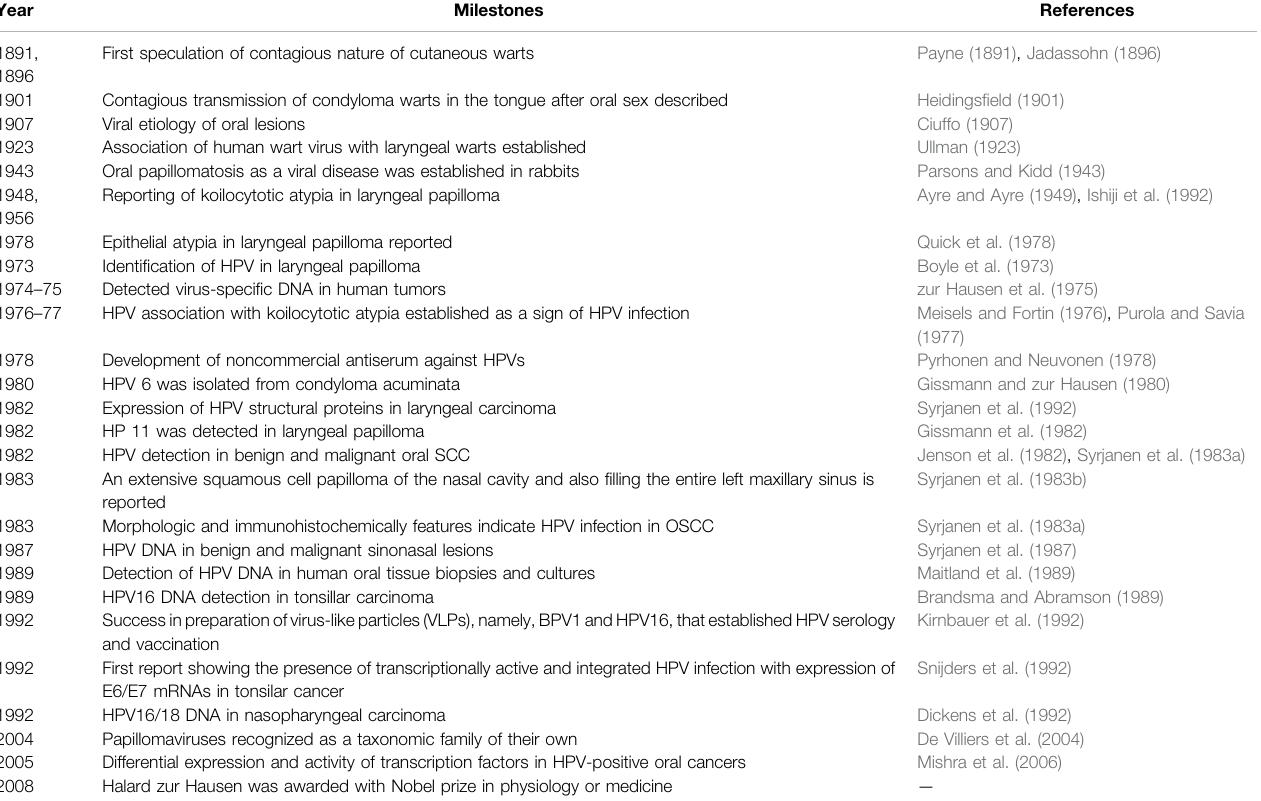
TABLE 1 | Major historical milestone events in the description of HPV infection in the head and neck region (adapted from Syrjanen et al.